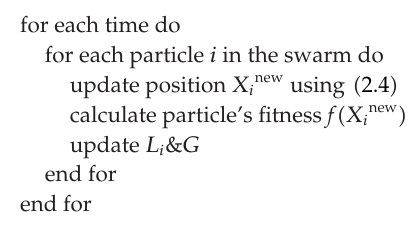
Algorithm 1: The pseudocode of the PSO update